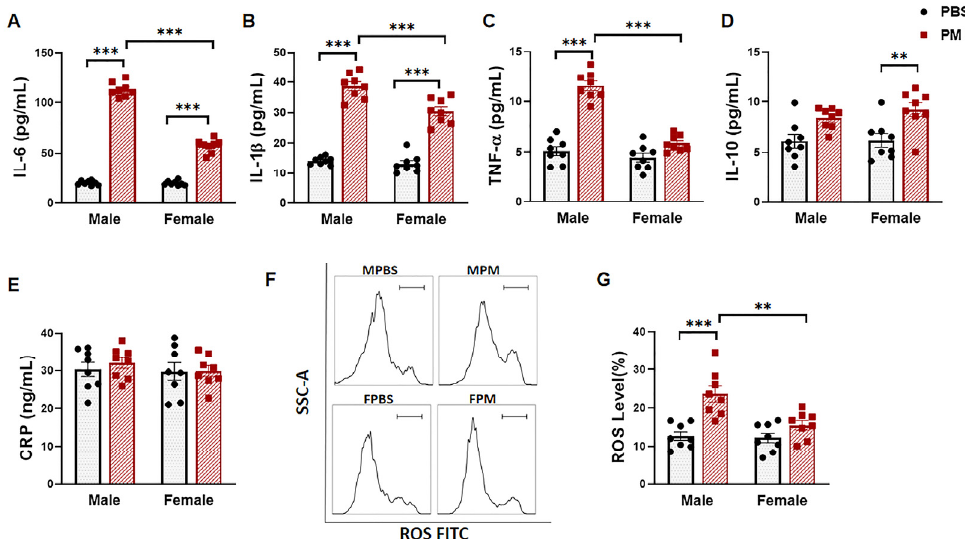
Figure 2. PM exposure increased serum cytokines and ROS production. ( A – C ) Serum pro-inflammatory cytokines IL-6 ( A ) and IL-1 β ( B ) were significantly increased in both male and female mice with PM exposure compared to the PBS control, while the serum levels of pro-inflammatory cytokines in male mice were significantly higher than those in female mice. ( C ) pro-inflammatory TNF- α was significantly increased in male mice with PM exposure, but not in female mice. ( D ) Anti-inflammatory cytokine IL-10 was increased in female mice with PM exposure compared to the PBS control. ( E ) No significant change was observed in the level of serum CRP. ( F ) Flow cytometry analysis was used to detect the ROS in blood monocytes, with summary data ( G ) showing a significant increase in ROS production in male mice with PM exposure compared to the control group and female mice with PM exposure. MPBS: male mice with PBS treatment ( n = 8); MPM: male mice with PM exposure ( n = 8); FPBS: female mice with PBS treatment ( n = 8); FPM: female mice with PM exposure ( n = 8). ** p < 0.01 and *** p < 0.001.